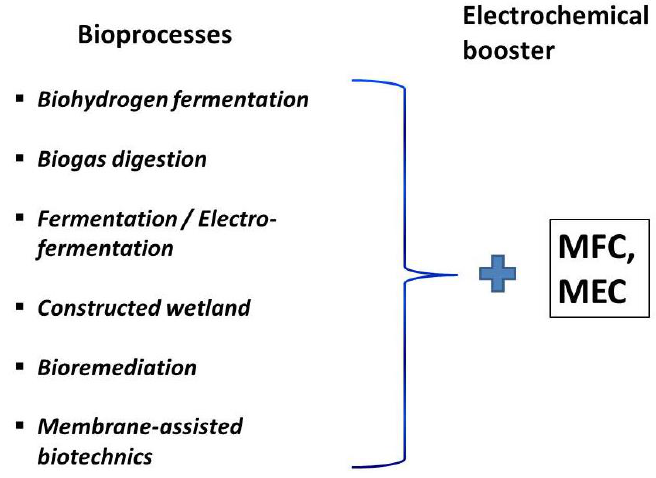
Figure 8. Potential bio-electrochemically boosted processes.